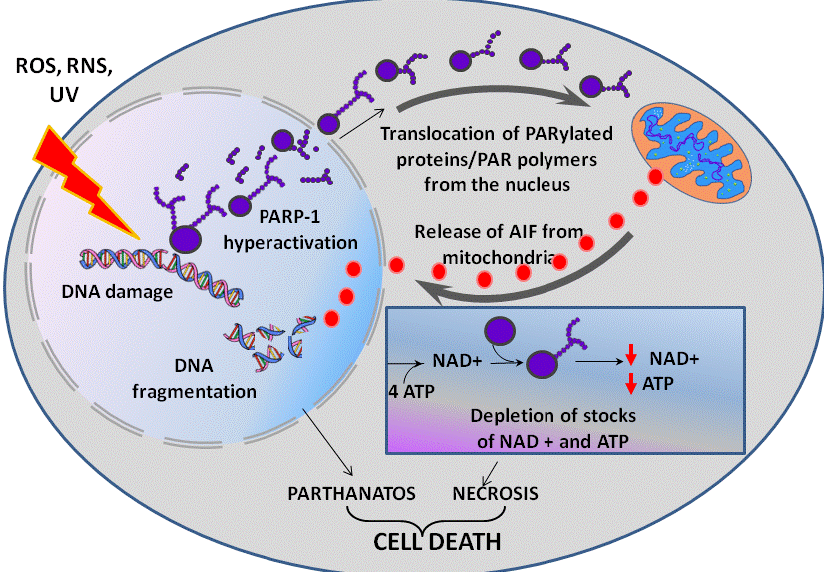
Figure 2. PARP-1 dependent cell death. UV — ultraviolet light, ROS — reactive oxygen species overproduced in oxidative stress, RNS — reactive nitrogen species (e.g., nitric oxide NO) overproduced in nitrosative stress. See text for detail.